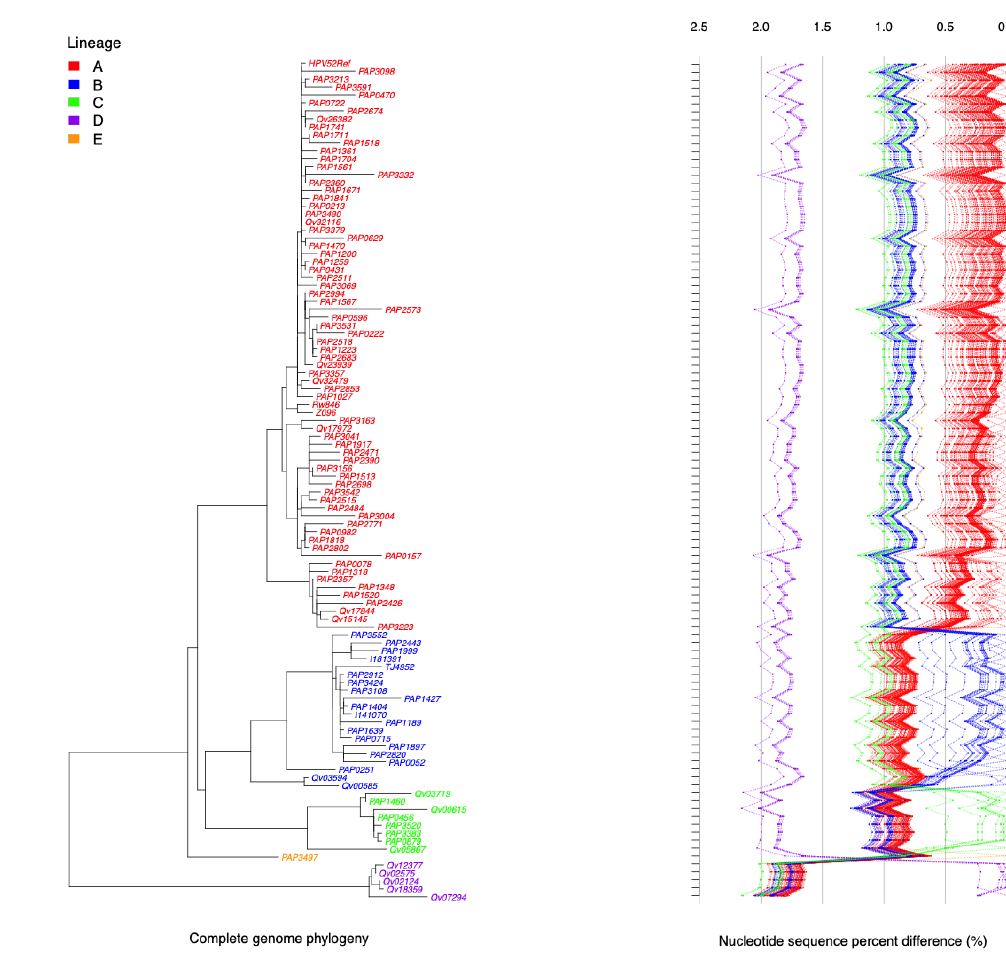
Figure 2. HPV52 phylogenetic tree topology and pairwise comparisons of individual complete genomes. The phylogenetic tree was inferred from global alignment of the complete nucleotide sequences from 106 HPV52 genomes. Distinct variant lineages (A, B, C, D, and E) were classified according to the topology and nucleotide sequence differences from >1% to <10% and are represented according to the color code shown at the top left of the figure. The percent nucleotide differences for each isolate compared to all other isolates are shown on the right. Lines indicate values for each comparison of a given isolate with the comparison to self as indicated by the 0% difference point to the far right.